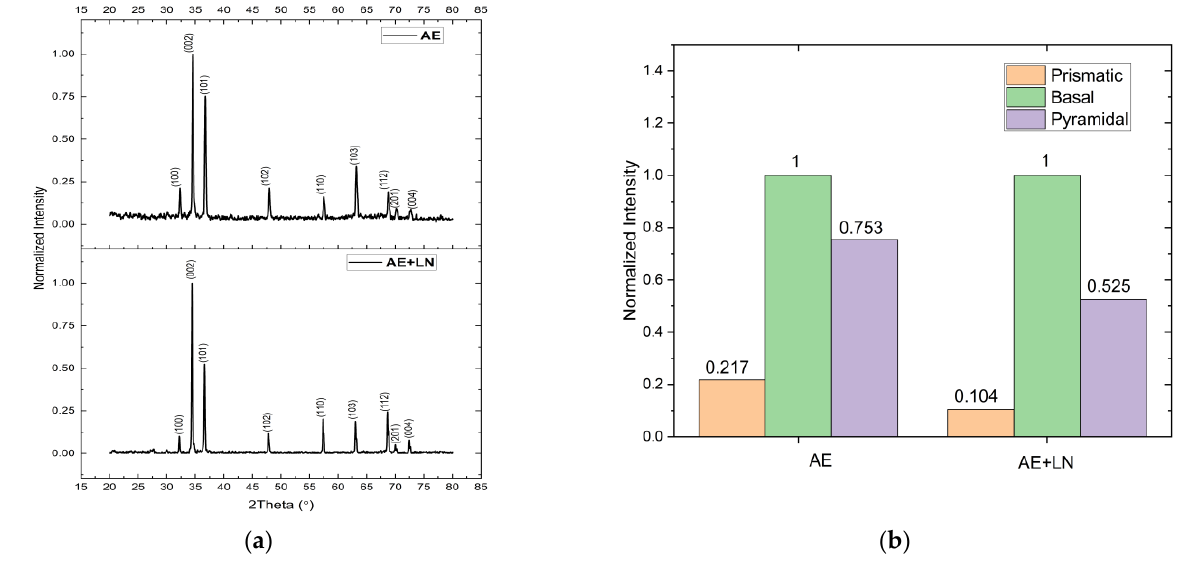
Figure 2. XRD results, taken in the longitudinal direction of the Mg/2wt.%CeO 2 samples. ( a ) Nor- malized XRD diffractograms; ( b ) The intensities of prismatic, basal and pyramidal planes.